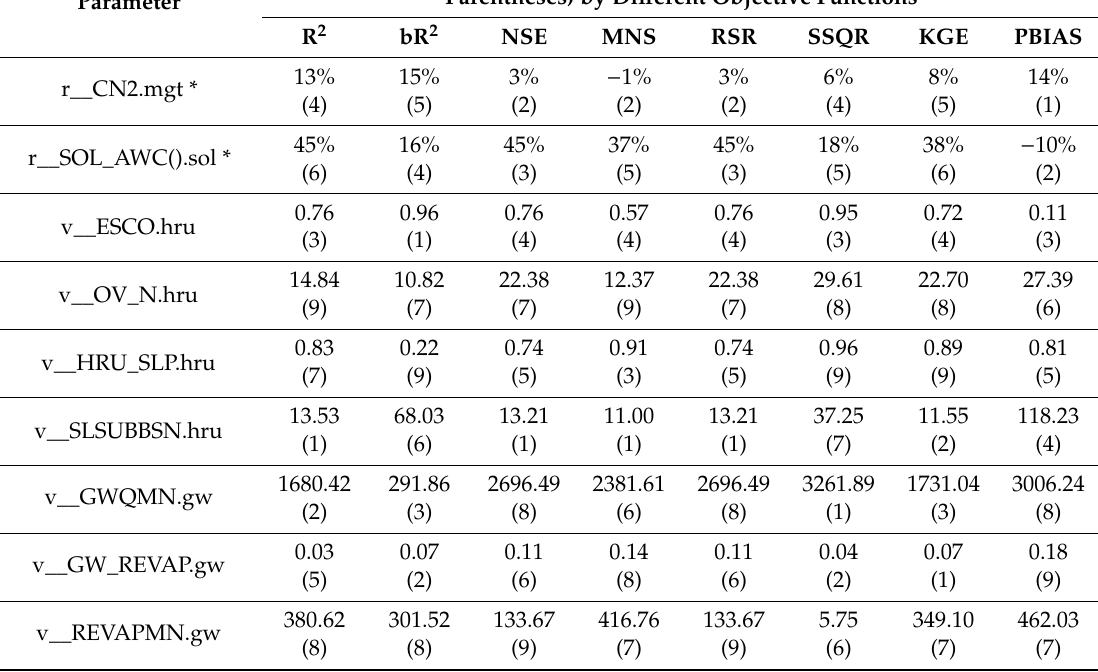
Table 5. Fitted values and sensitivity ranks (values in parentheses) of the calibrated parameters obtained from di ff erent objective functions during the calibration process. Fitted Parameter Values and Parameter Sensitivity Ranks (Values Parameter